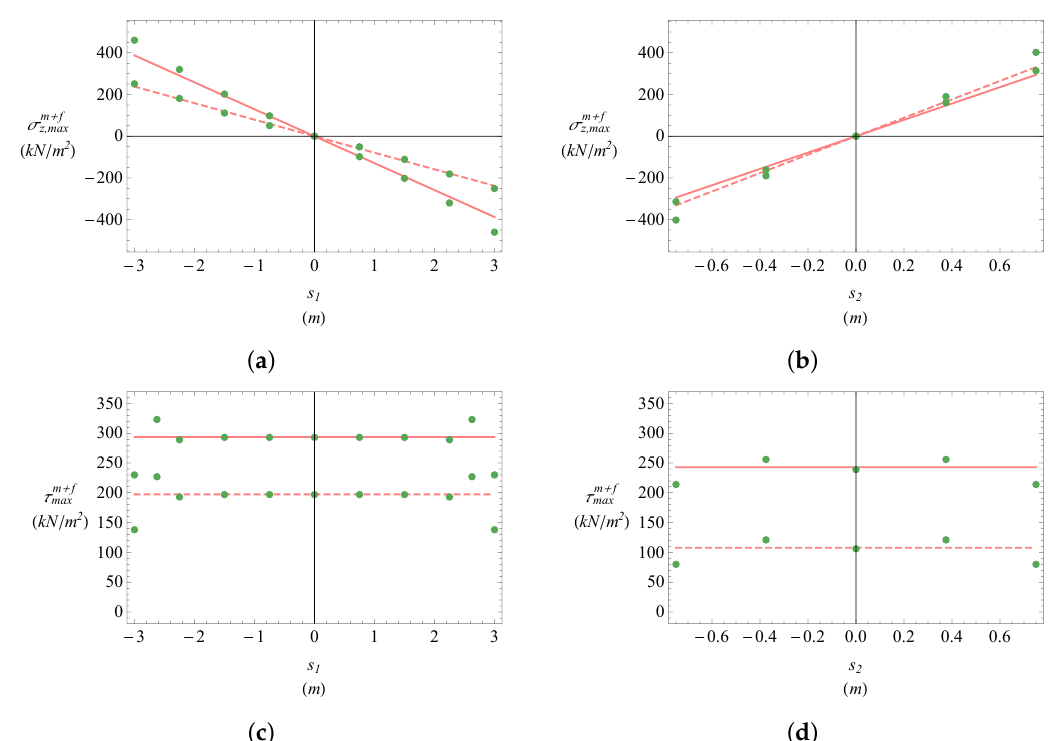
Figure 16. Torsion without distortion: longitudinal normal stresses and tangential stresses at the cross section z = 7.5m vs. s i ; bottom edge (continuous line), top edge (dashed lines); ( a , b ) σ m ( a , b ) element 1, ( c , d ) element 2. Fourier analysis with N = 50 terms, FEM analysis (bullets).